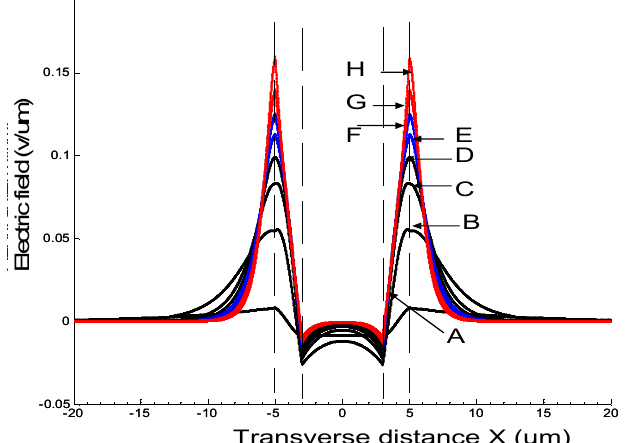
Figure 7. The electric field distributions with respect to the eight points, A, B, C, D, E, F, G, and H, as shown in Figure 6.